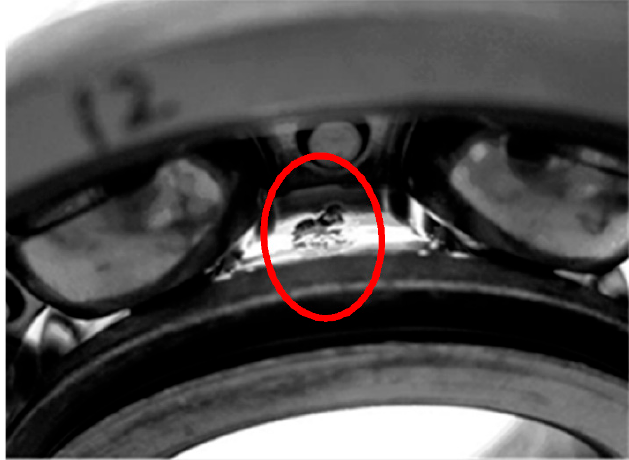
Figure 12. The failure bearing B1.